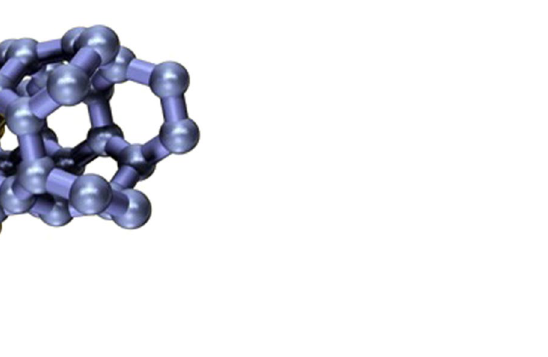
Figure 2. Structure of